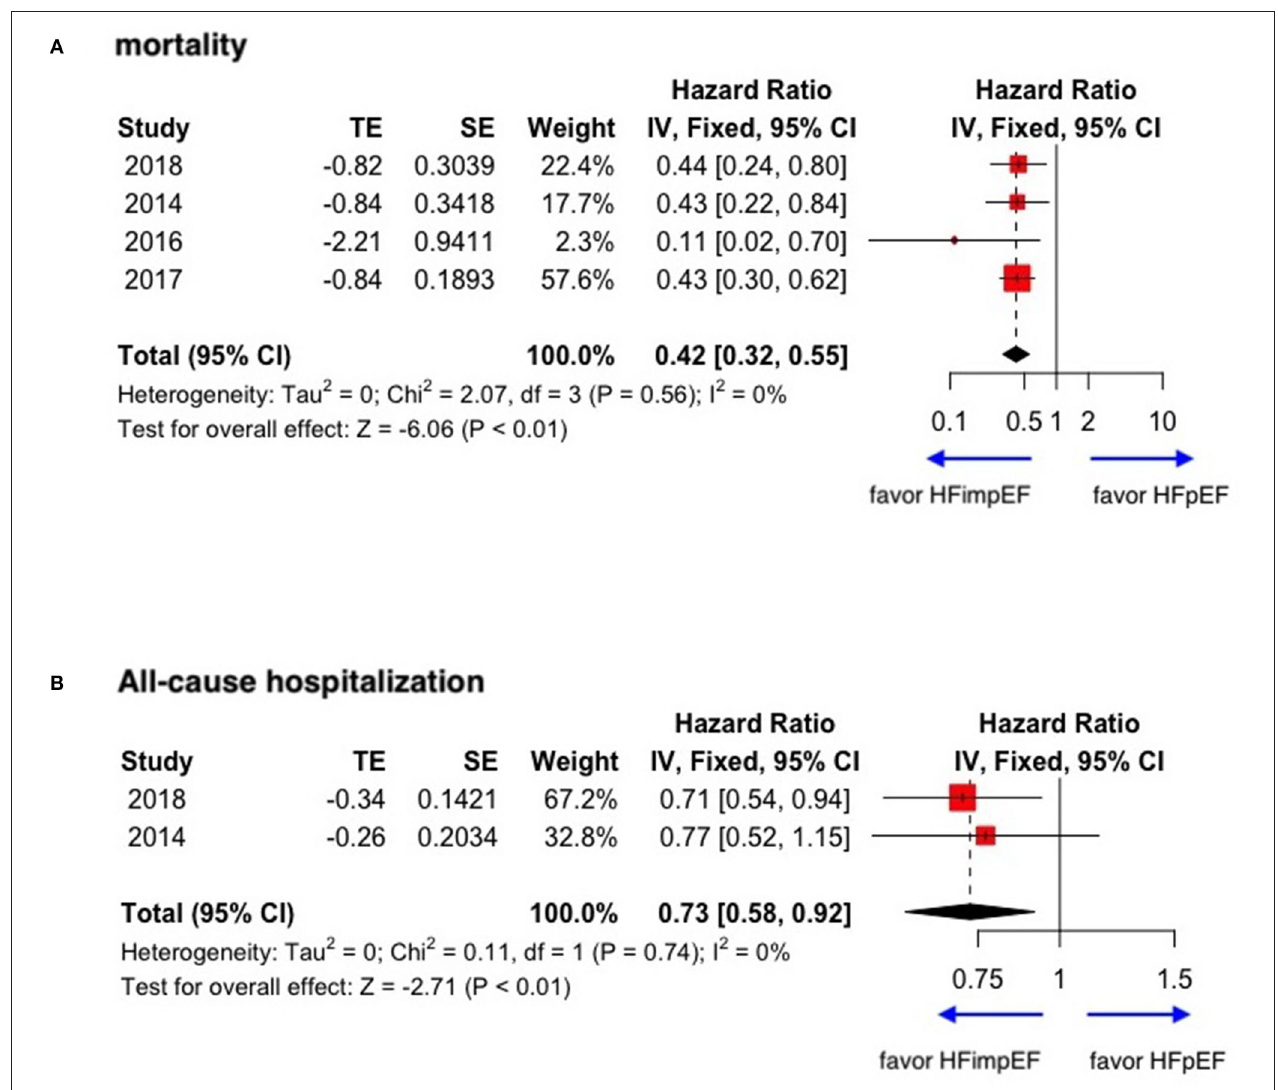
FIGURE 6 | Forest plots of mortality and all-cause hospitalization in patients between HFimpEF and HFpEF. (A) Mortality. (B) All-cause hospitalization.